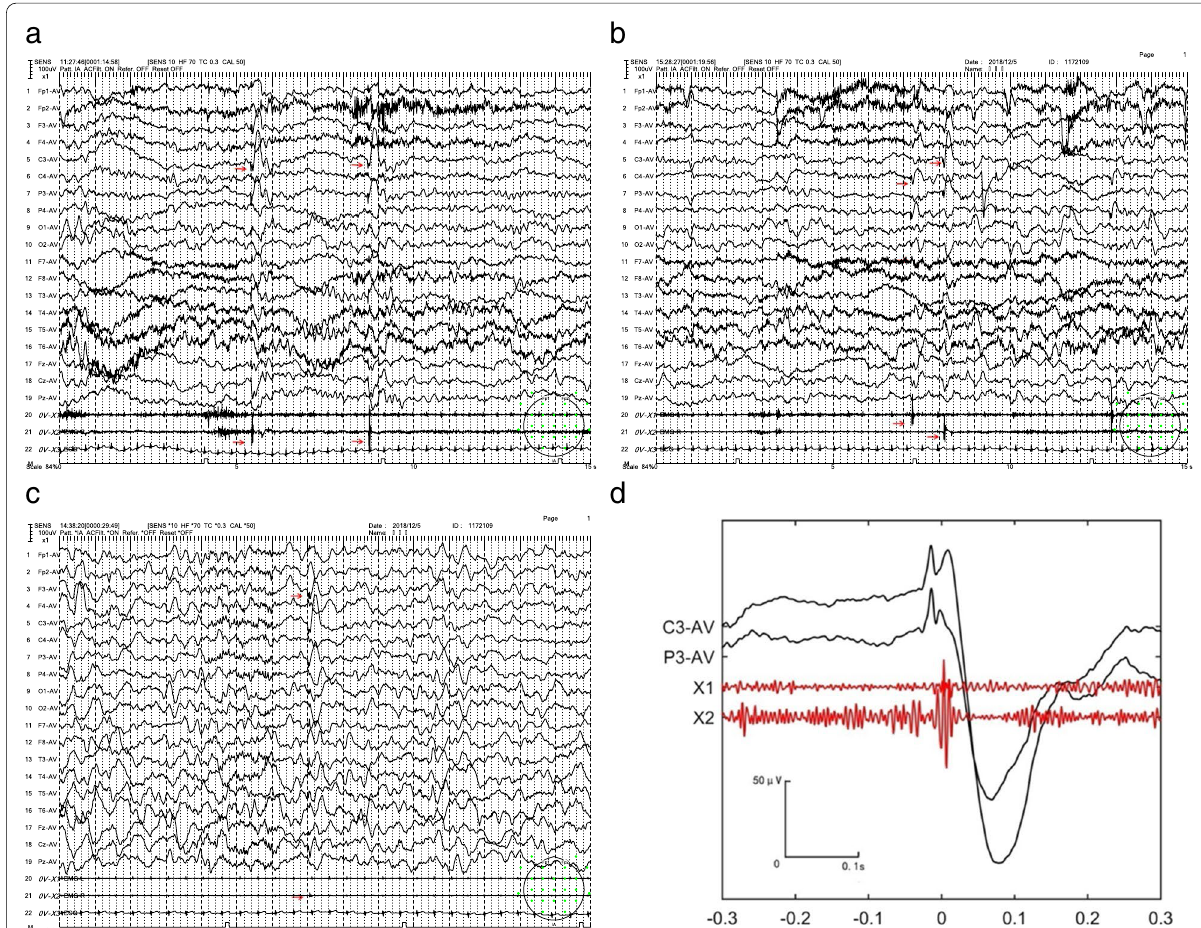
Fig. 2 Results displayed ictal EEG and back-averaging of of the ictal EEG data. a and b . A visible spike wave at left central-parietal cortex immediately preceded a right myoclonic muscle activity,while a visible spike wave at right central-parietal cortex immediately preceded a left myoclonic muscle activity. c . A visible spike wave at left central-parietal cortex immediately preceded a right myoclonic muscle activity during sleep. d . Jerk-locked averaging discloses a pre-myoclonic negative peak predominantly at the central-parietal electrode; this peak precedes the EMG onset by approximately 42 ms. Electromyogram: on both deltoid muscles. The red line represents the abnormal electrical activity in the brain and burst of EMG activity. EEG: